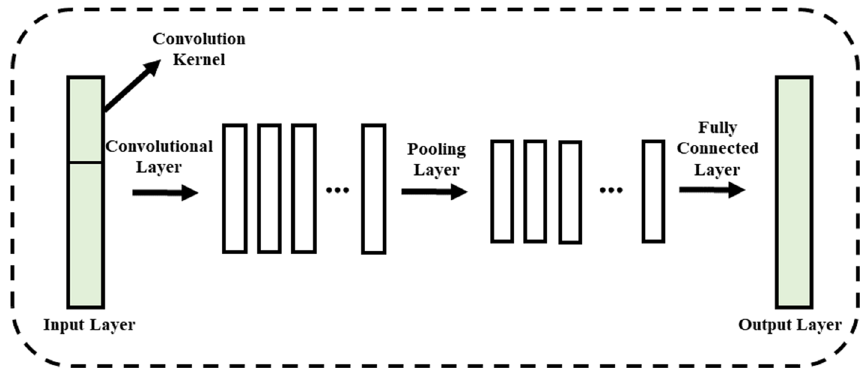
Figure 1. Structure of the one dimensional convolutional neural